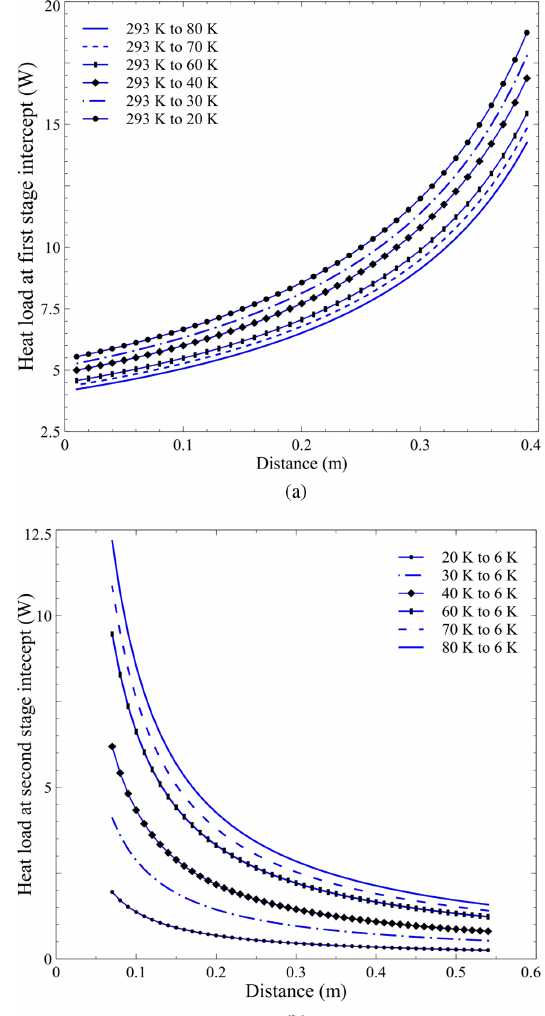
FIG. 6. Heat loads at first and second intercepts with change in distance and operating